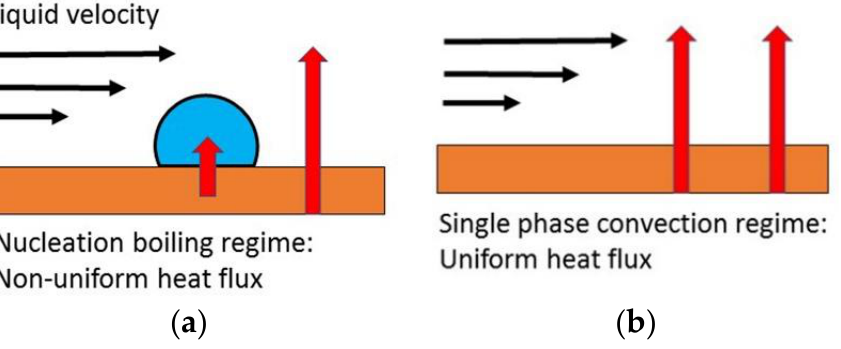
Figure 3. Schematic comparison of heat transfer distribution from a workpiece when quenching under: ( a ) nucleation boiling regime, in which heat flux through vapor bubbles is smaller than heat flux to the liquid and ( b ) single phase convection regime, where heat flux in uniform through the wall surface.